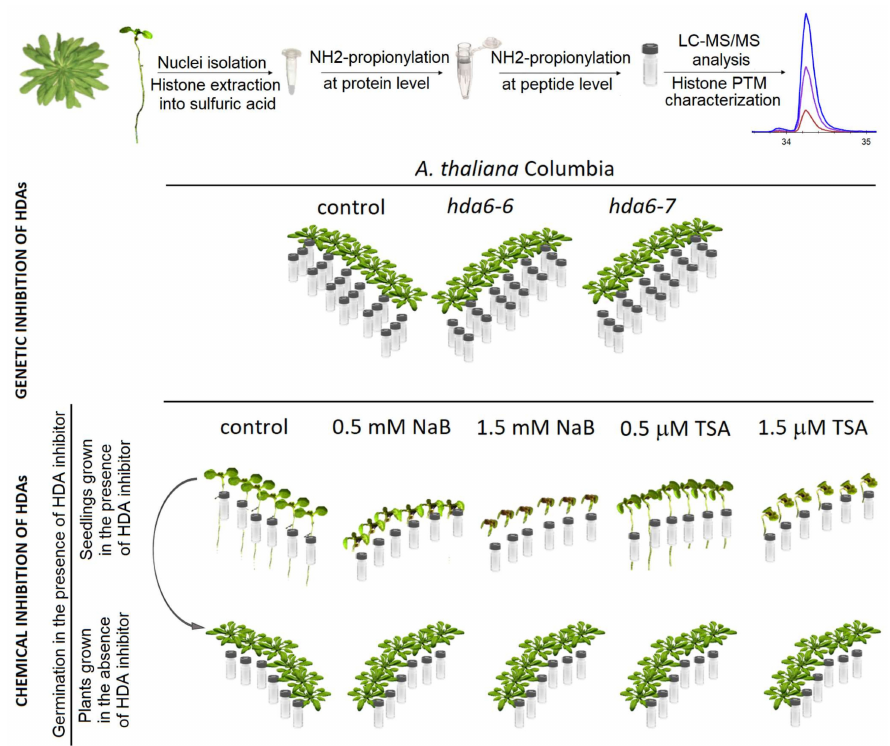
Figure 2. Experimental design. To quantify histone marks levels, histone proteins were extracted from seedlings germinated on di ff erent Petri dishes (6 replicates) or leaves of six independently cultivated plants. Samples were prepared for analysis by filter-aided sample preparation coupled with histone propionylation, digested with trypsin, and analyzed by LC-MS / MS. Leaves collected from 7-week-old hda6 mutants and respective wild type plants were analyzed in a random order in three technical batches. Part of 7-day-old seedlings germinated in the presence of HDA inhibitors was harvested for proteomic analysis and part was transferred to the soil without HDA inhibitors and plants were grown for 7 weeks. These samples were analyzed in a random order in a single technical